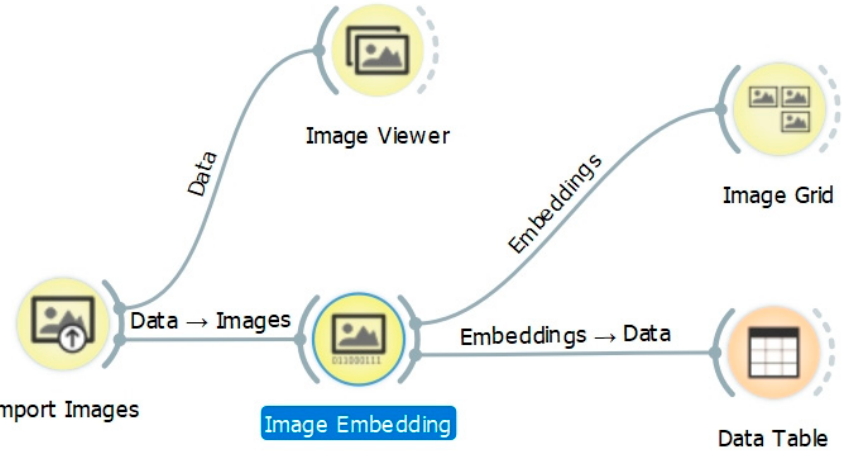
Figure 1. Workflow in Orange with widgets from the Image Analytics add-on.